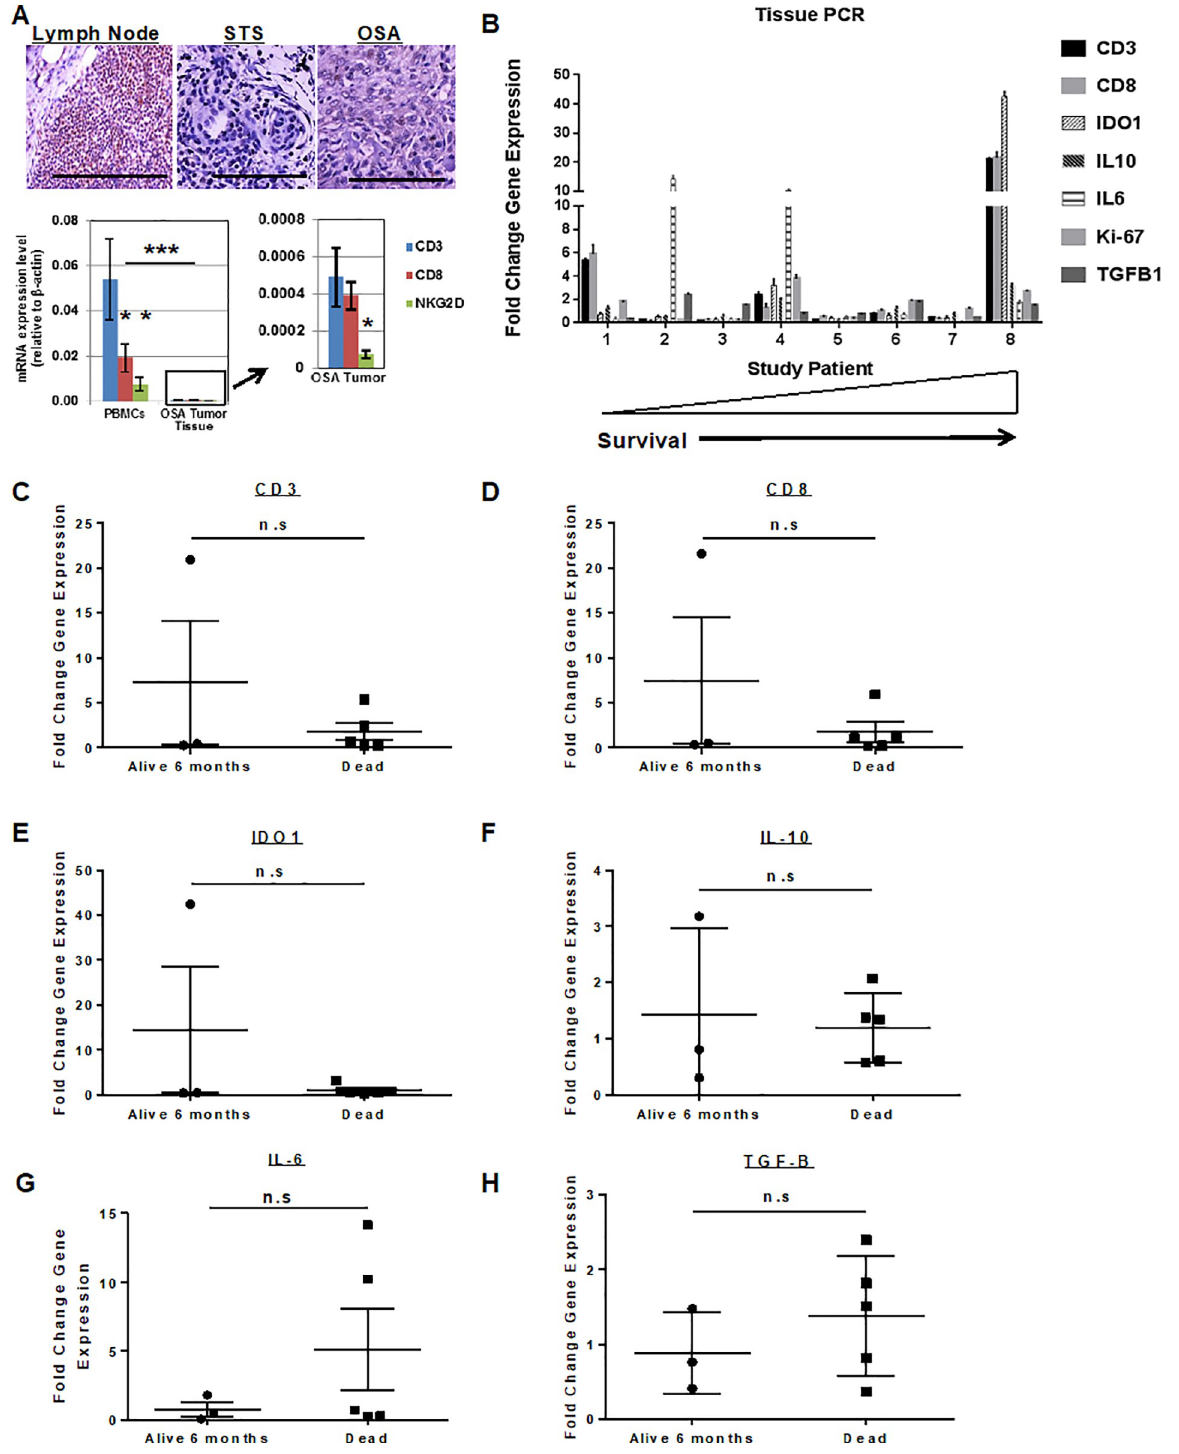
Fig 5. Intra-Tumoral immune cell infiltration and gene expression in dog sarcomas. (A) Lymph node from a dog necropsy specimen was compared to tissue from untreated dog soft tissue sarcoma and osteosarcoma cases. Immunohistochemical staining for CD3+ cells revealed high infiltration in normal lymph node (left) versus rare to absent lymphocyte presence in soft tissue sarcoma (middle) or osteosarcoma (right) tumors. Scale bar = 200 μ m. RNA analysis by PCR of PBMCs from healthy dogs (A–bottom left) demonstrated greatest expression of CD3 compared to CD8 or NK marker NKG2D. Expression of these genes in PBMCs was approximately 100-fold greater than expression in